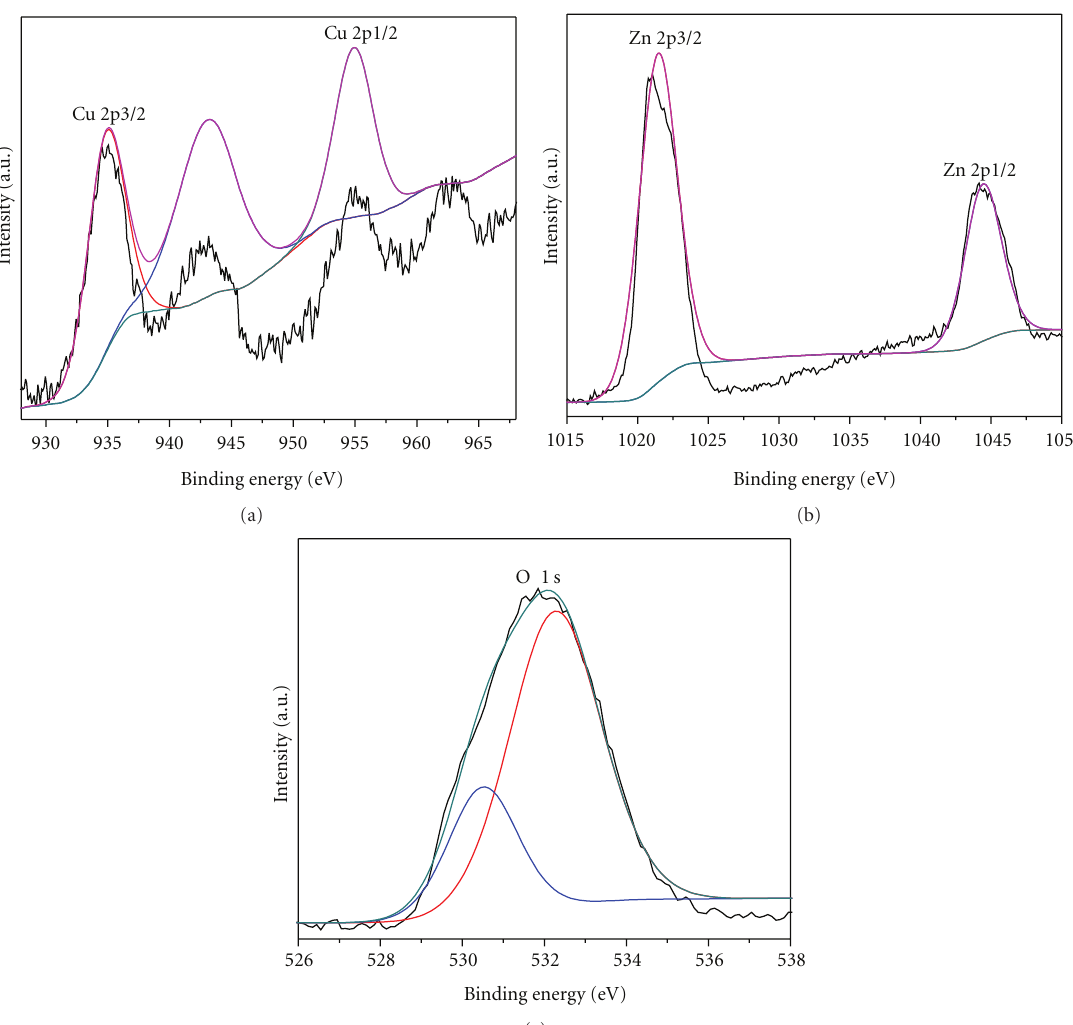
Figure 4: XPS spectra of the Cu2p, Zn2p, and O 1s state on the surface of the hierarchical CuO/ZnO nanomaterials.